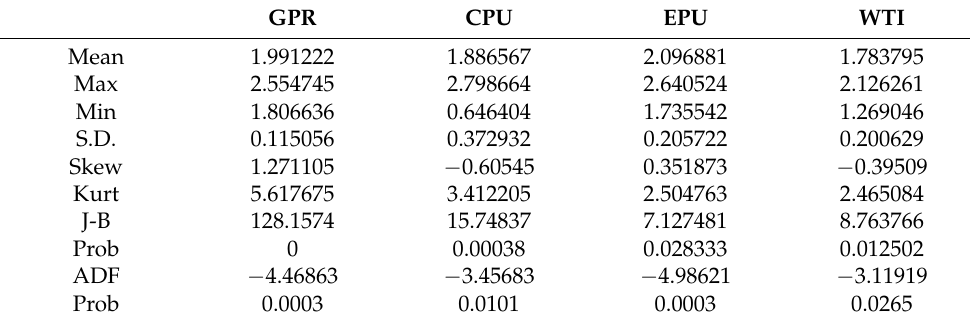
Table 2. Descriptive